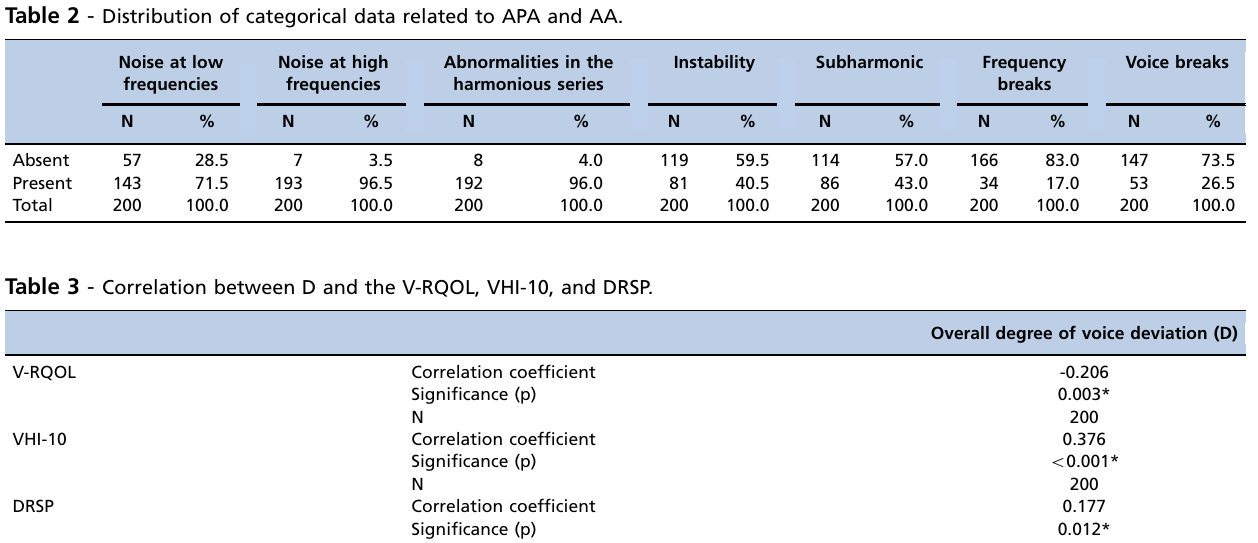
Spearman ’ s correlation test; *statistically significant. Table 4 - Comparison between the DRSP-General score tertiles and the overall degree of voice deviation. Overall degree of voice deviation